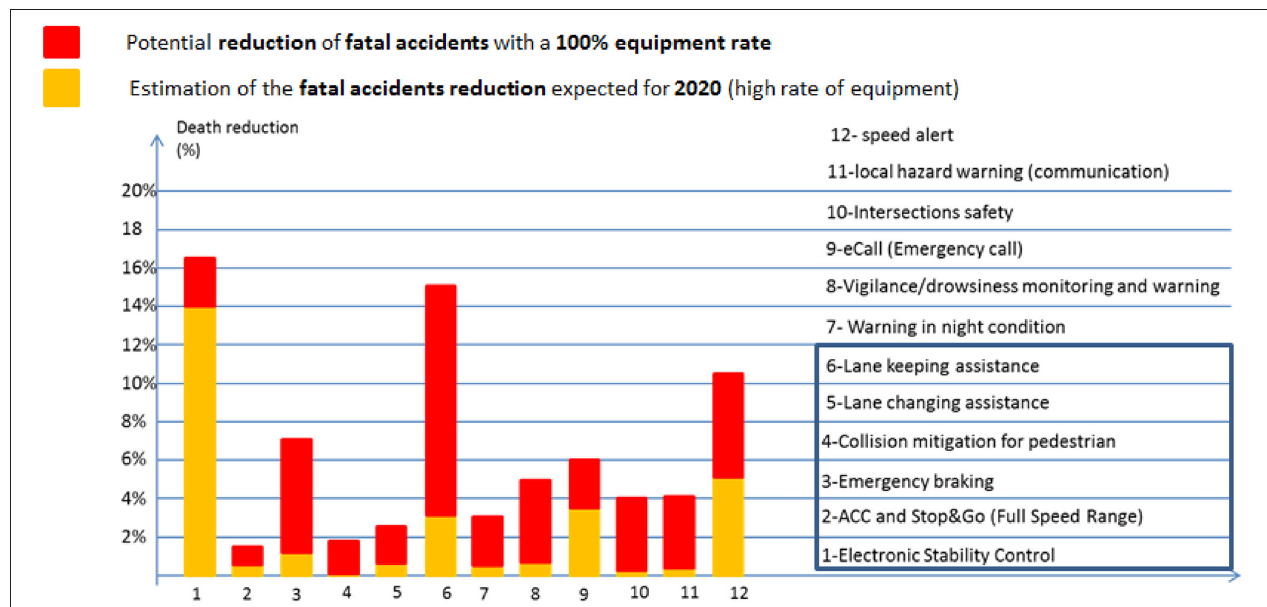
FIGURE 6 | Benefit (in percentage reduction in fatalities) of 12 ADAS. Assessment made in eIMPACT project (eIMPACT project, 2008) for 2020 extrapolation scenario.